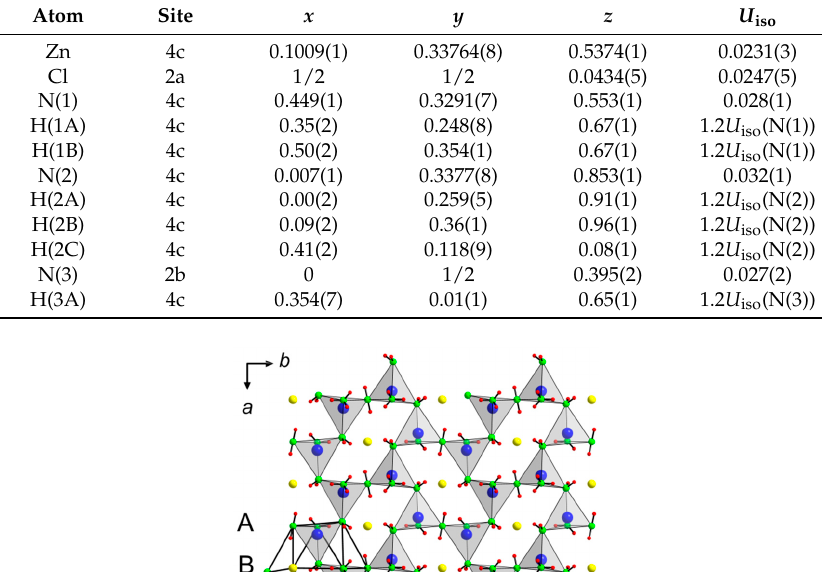
Table 2. Positional and isotropic displacement parameters U iso (10 4 pm 2 ) for [Zn 2 (NH 3 ) 2 (NH 2 ) 3 ]Cl.